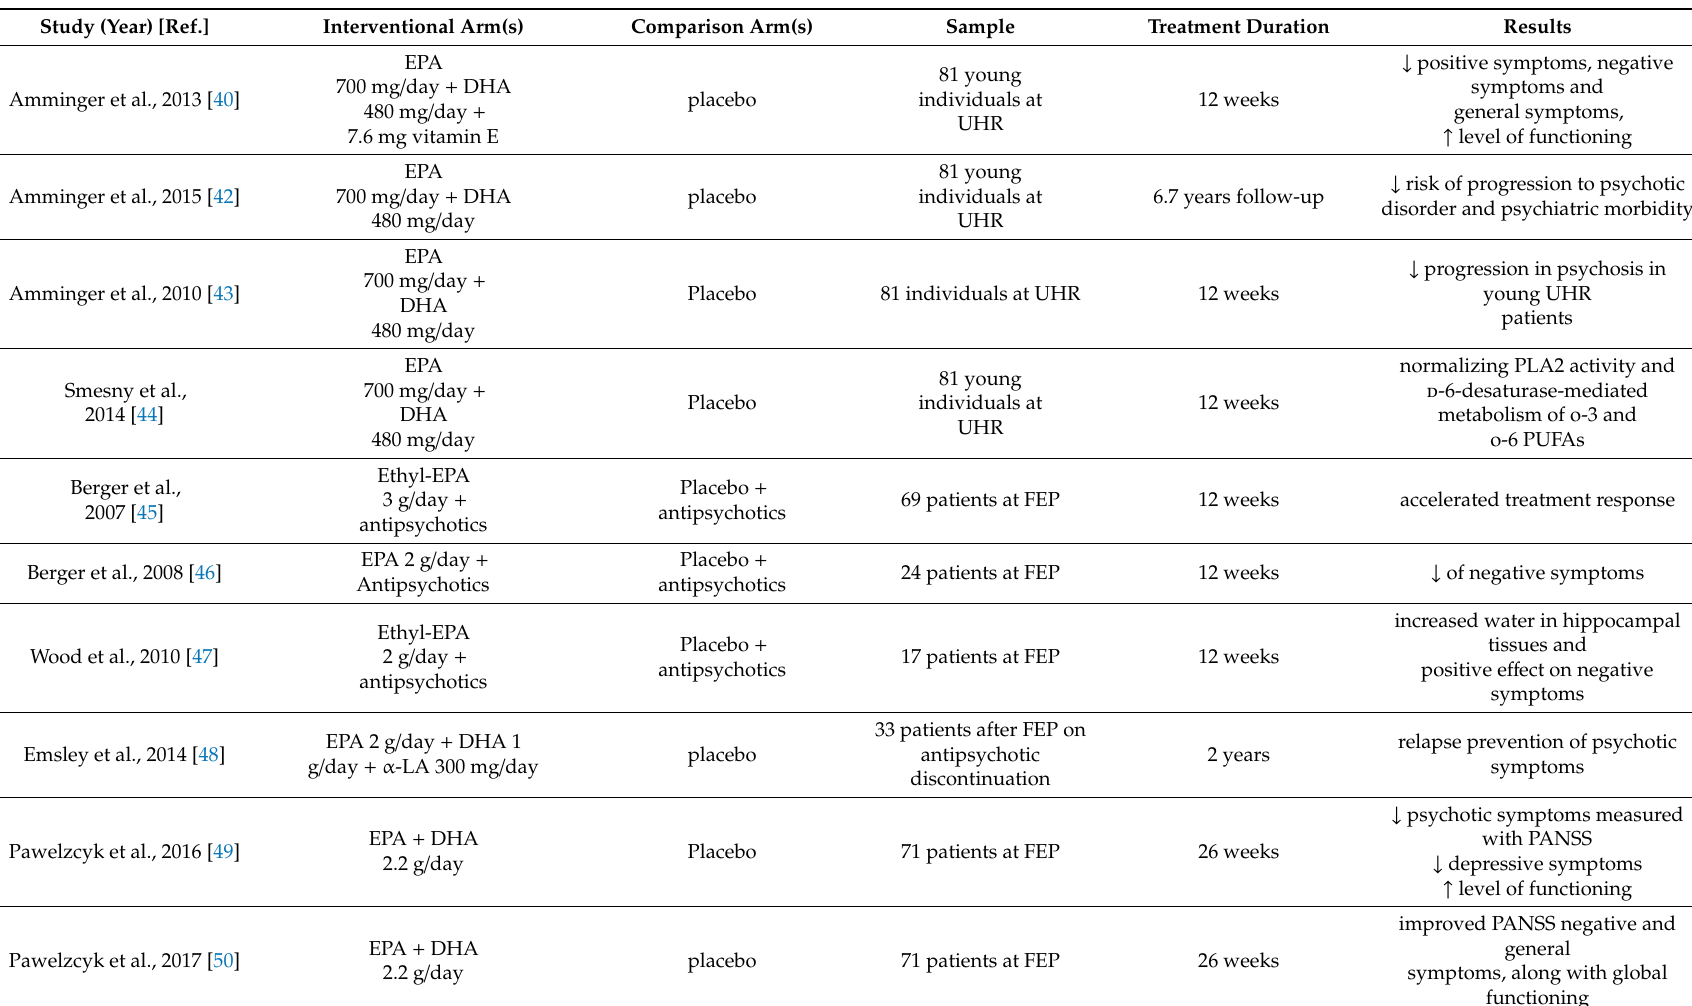
Table 1. Randomized controlled trials and open trials of omega-3 PUFAs on psychotic